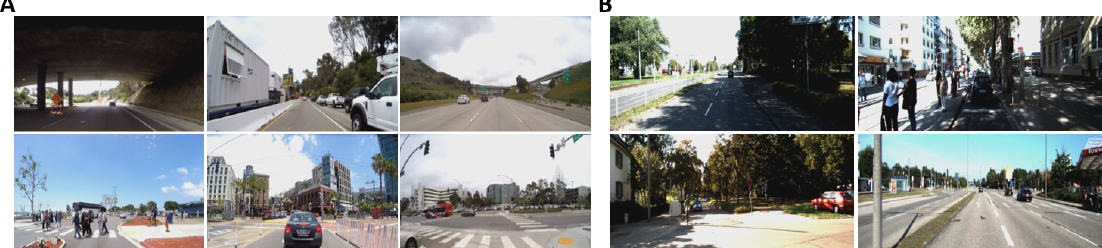
Figure 6. Various image instances with varying illumination conditions and type of road (street, single-lane, highway, etc.) from ( A ) LISA Dataset and ( B ) KITTI